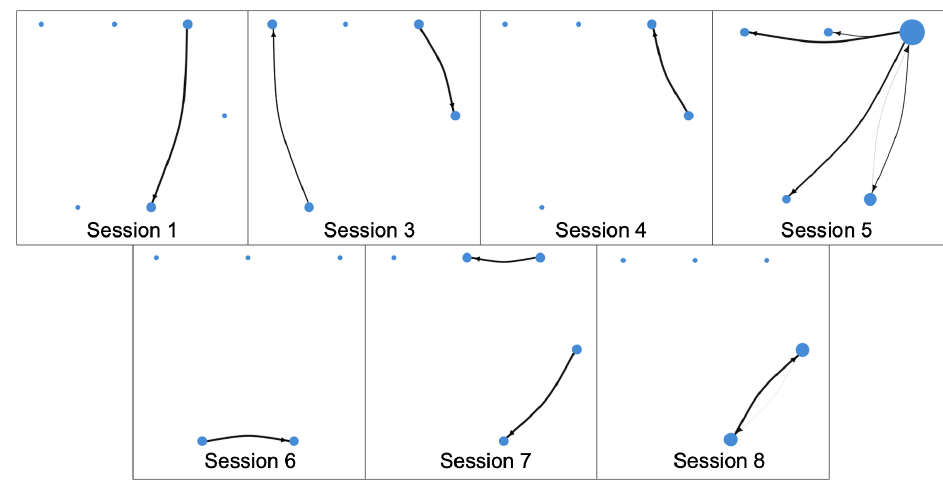
FIG. 15. Network diagrams for all coded sessions of section